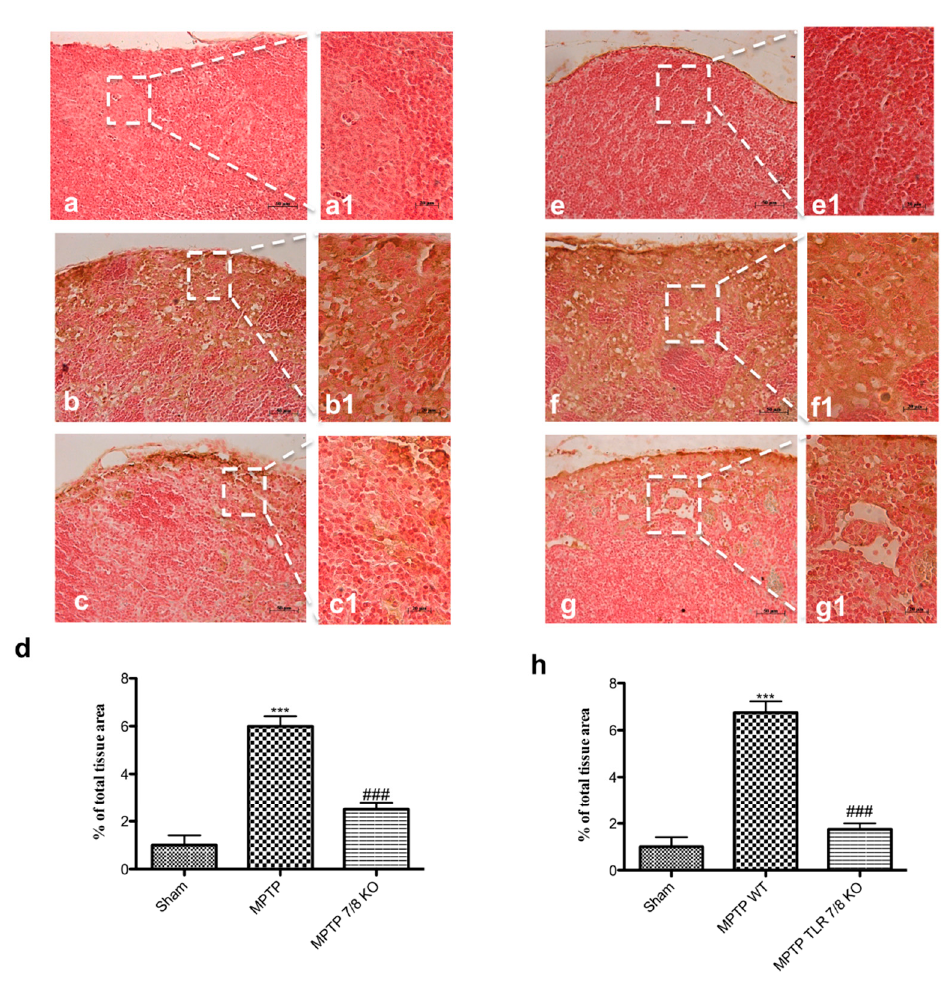
Figure 11. Effect of TLR7 / 8 on CD4 + and CD8 + expression. Immunohistochemical of CD4 + and CD8 + T cell reveal an increase for both in MPTP WT mice ( b , b1 , f , f1 , respectively; see densitometric analysis d , h ), compared to WT mice ( a , a1 ) while the absence of TLR 7 / 8 markedly reduced positive staining for CD4 + ( c , c1 see see densitometric analysis d ) and CD8 + T cell ( e , e1 see see densitometric analysis h ) ( c , c1 , g , g1 , respectively; see densitometric analysis d , h ). Data are means ± SEM of 10 mice for each group. *** p < 0.001 vs. SHAM WT; ### p < 0.001 vs. MPTP WT.